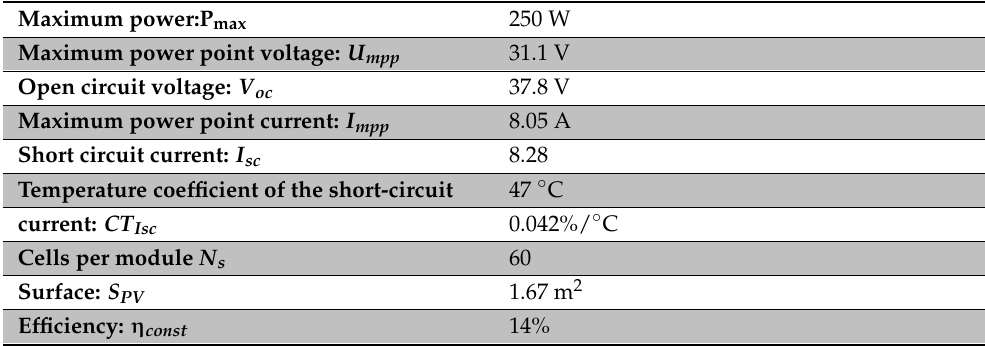
Table 1. Characteristics of the PV